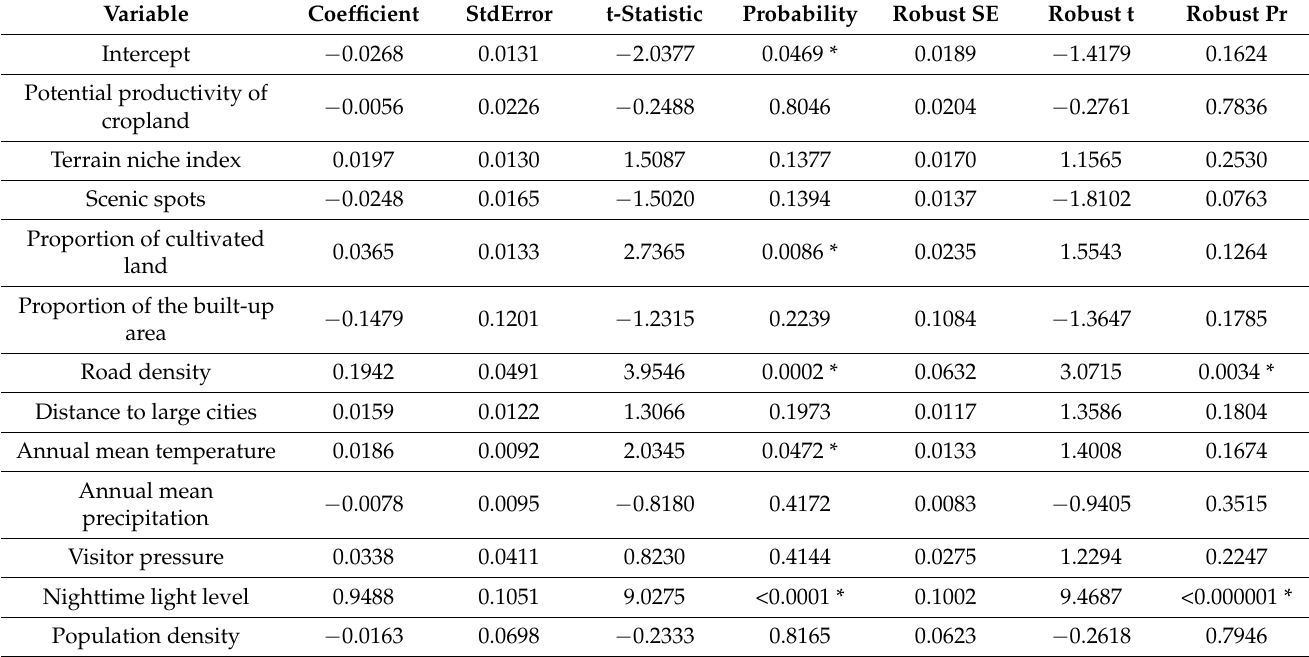
Table 4. The results of the OLS model including the SPLIT and 12 selected independent